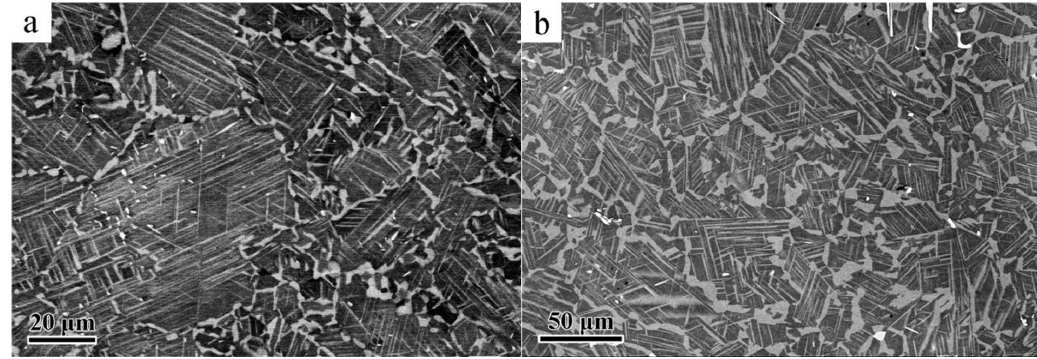
Figure 5. SEM images of the microstructures following annealing at 1250 °C for 5 min ( a ) and 2 h ( b ) after water-quenched from 1340 °C.